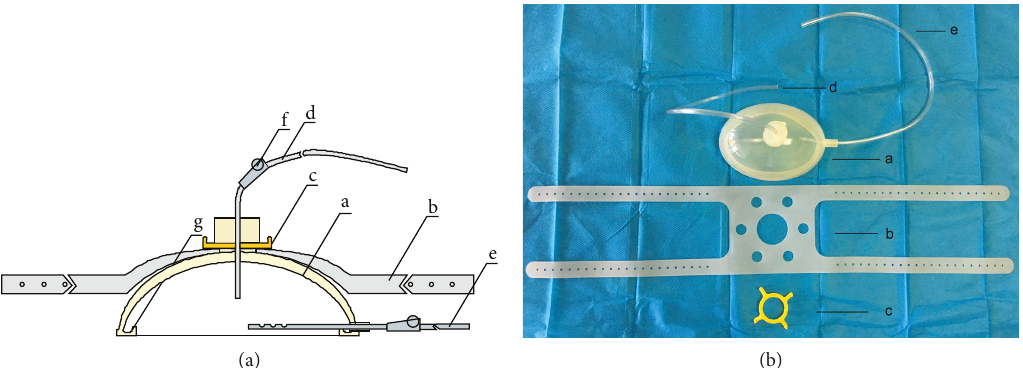
Figure 1: The design and fi gure for a portable peritoneal lavage device. (a) The design of the portable peritoneal lavage device, and (b) the physical map of the device. It consists of three parts: an abdominal cover (A), a strap (B), and a fi xed bracket (C). The abdominal cover is the main part of the device, including the main body of the abdominal cover and the inlet and outlet pipes (D and